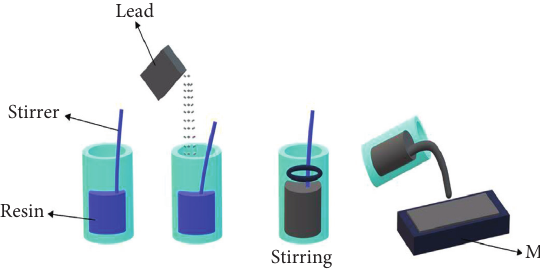
Figure 1: Schematic of layered molding and curing route. Table 1: Composition of single-layered samples and the density of the